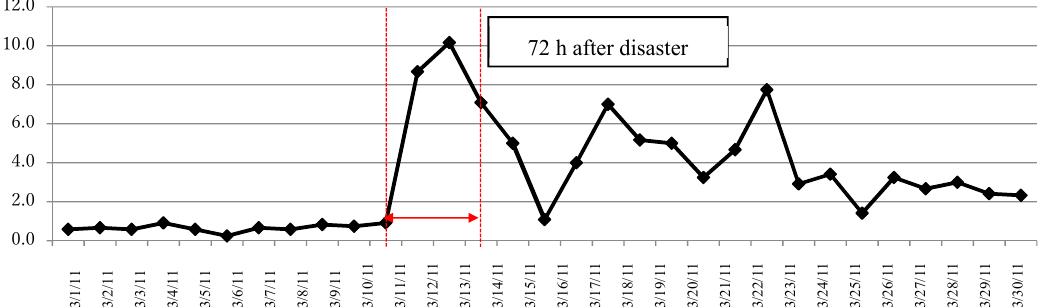
Figure 3. Mean hourly aircraft arrival rate at Hanamaki Airport after the Great East Japan Earthquake (units: number of aircraft / h, source: flight movement data of Ministry of Land, Infrastructure, Transport and Tourism (MLIT), Japan). Table 3. Applying queuing priority to each aircraft operator (1 to 5: highest to lowest).